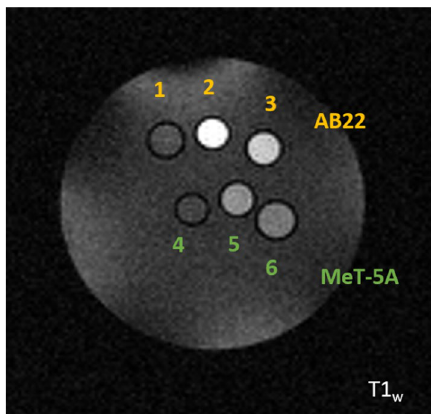
Figure 3. T 1w MRI image of glass capillaries containing AB22 and MeT-5A cell pellets incubated with PLGA- CTRL (3 and 6), PLGA-His (2 and 5) and untreated control cells (1 and